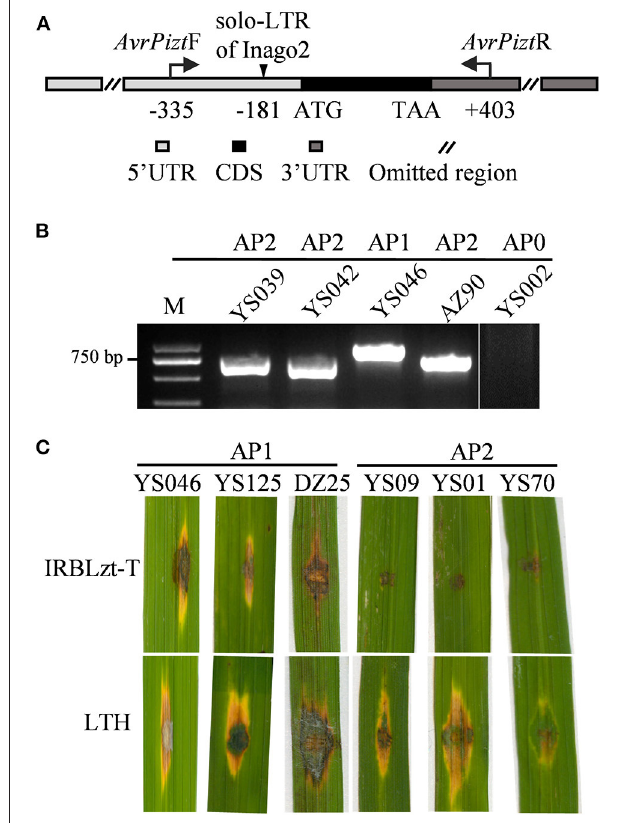
FIGURE 5 | AVR-Pizt variants and their pathogenicity to IRBLzt-T. (A) Schematic diagram of AVR-Pizt and the insert site of a solo-LTR of Inago2. (B) Amplification patterns of AVR-Pizt from the indicated isolates. The primers AvrPiztF / AvrPiztR were used to distinguish three alleles. AP0 indicates no amplicon. AP1, AP2, and AP3 indicate different sizes of amplicons. (C) Pathogenicity of representative strains on the monogenic line